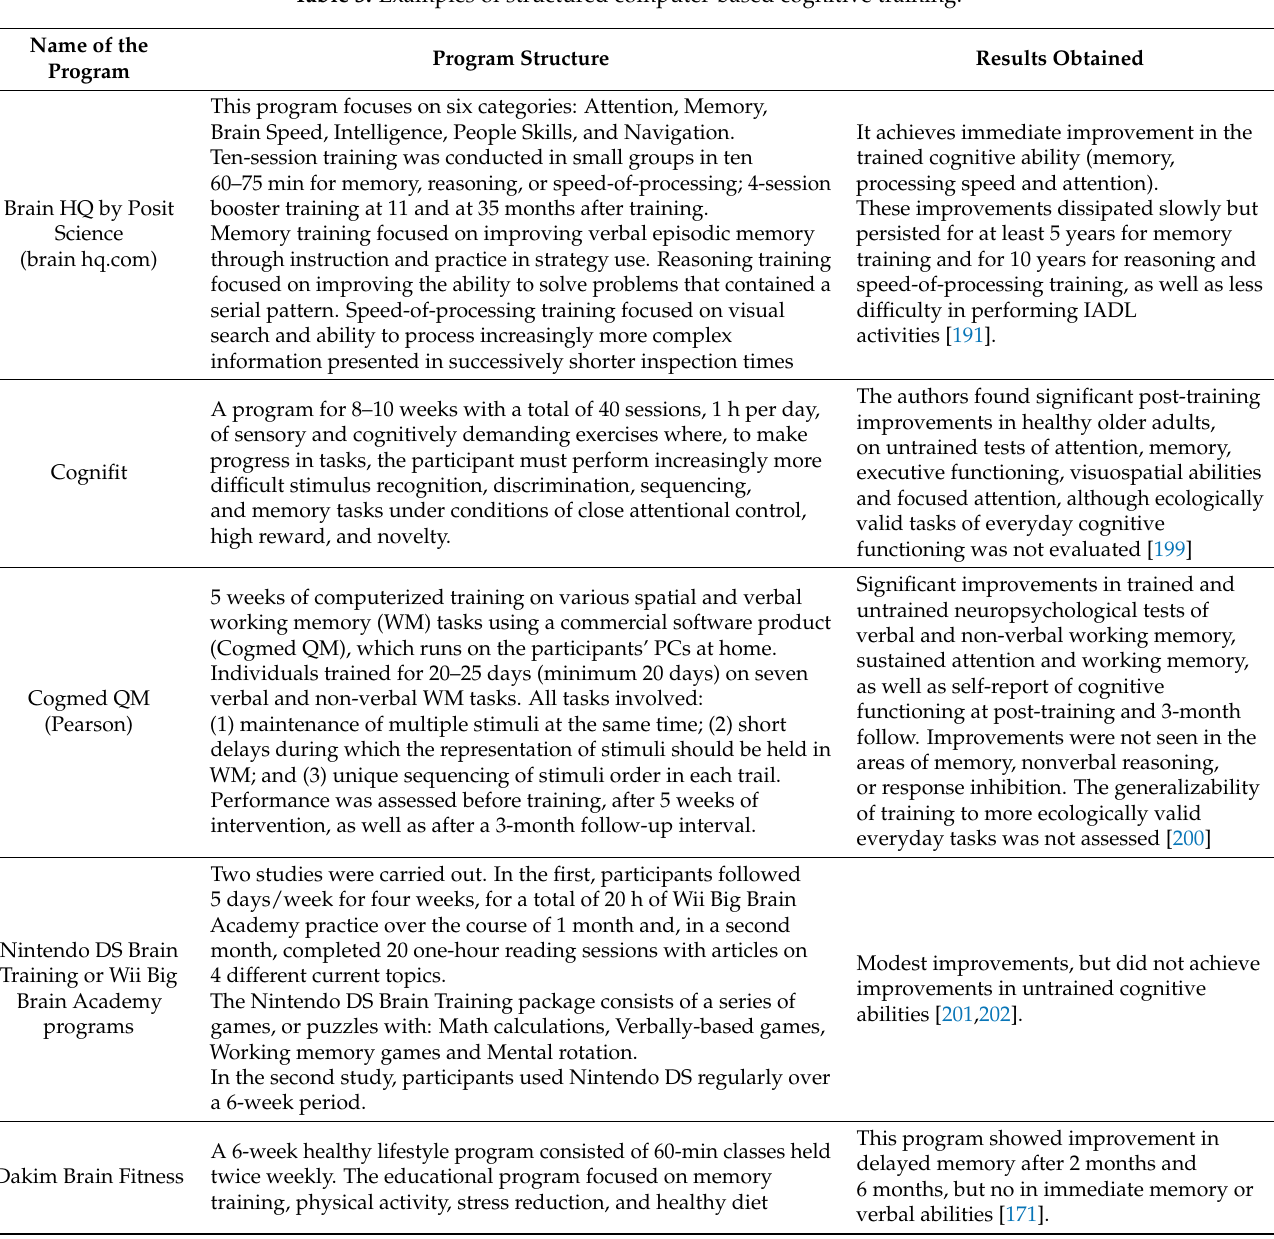
Table 3. Examples of structured computer-based cognitive